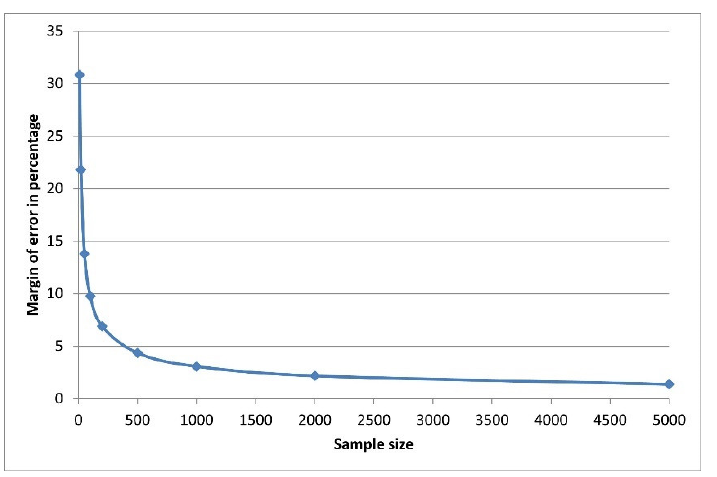
Figure 2. Margin of error as a function of the sample size for a 95% confidence level and 50% proportion percentage.